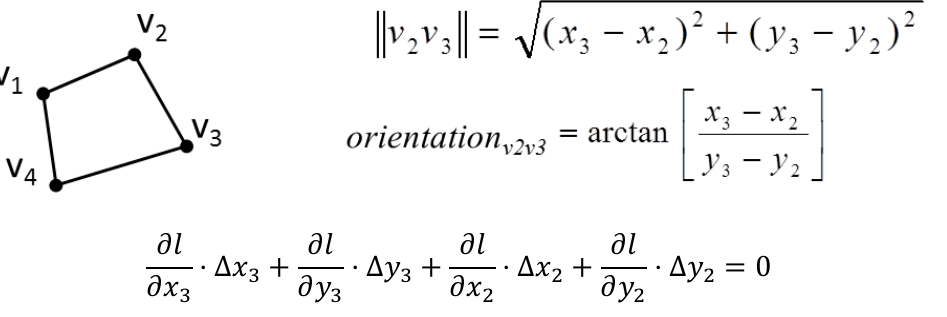
Figure 5. Nonlinear equations for segment length and orientation in a stiff